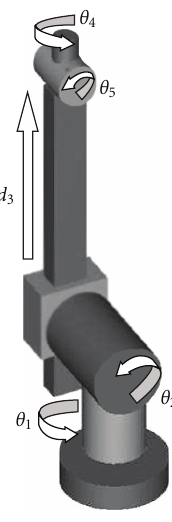
Figure 1: Five degrees of freedom Robot Manipulator.